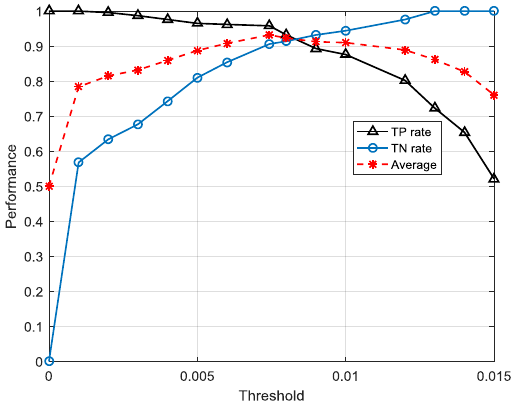
Figure 16. Performance change with increasing threshold.